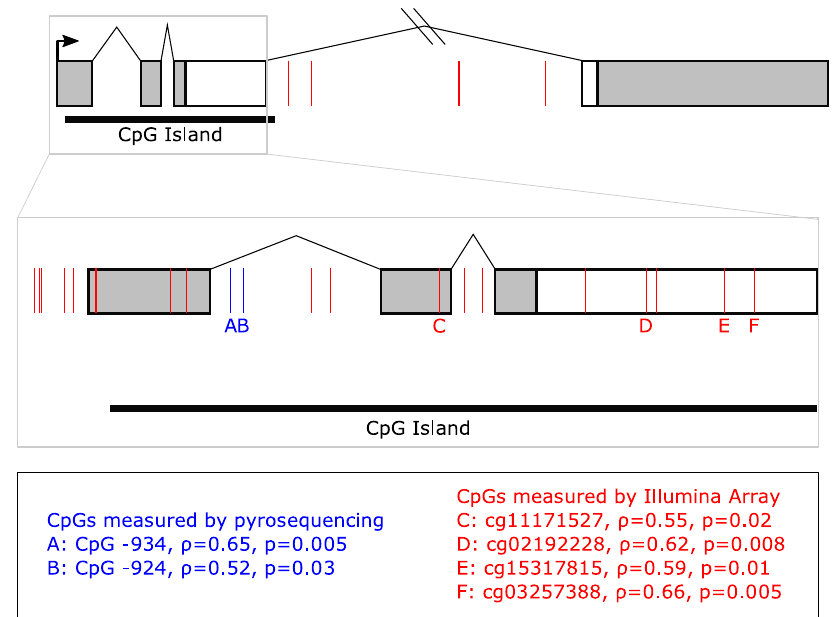
Fig. 1 OXTR gene schematic and location of CpG sites with signi fi cantly correlated methylation. Gene schematic of OXTR . Boxes represent exons and lines represent introns. Coding regions are in white and untranslated regions are in gray. The black arrow indicates the transcription start site. The black bar below the gene denotes the CpG island. The 5 ’ region of the gene is enlarged to show detail. Blue lines indicate CpG sites assayed by pyrosequencing and red lines indicate CpG sites assayed by Illumina Methylation EPIC 850 K array. CpG sites with signi fi cantly correlated DNA methylation in blood and myometrium are indicated by letters and Spearman ’ s rho is reported below the gene schematic.